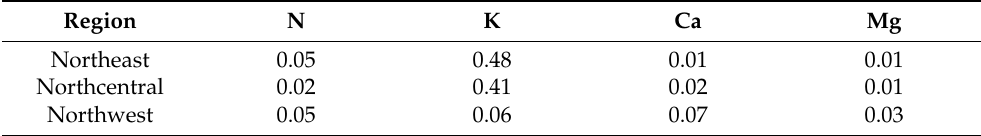
Table A2. Augmented Dickey–Fuller unit root test p -values indicating most processes are white- noise ( α = 0.05) after differencing and log transformation. All K values fail the test, however, when excluding the 2017 values the processes appear to be detrended or